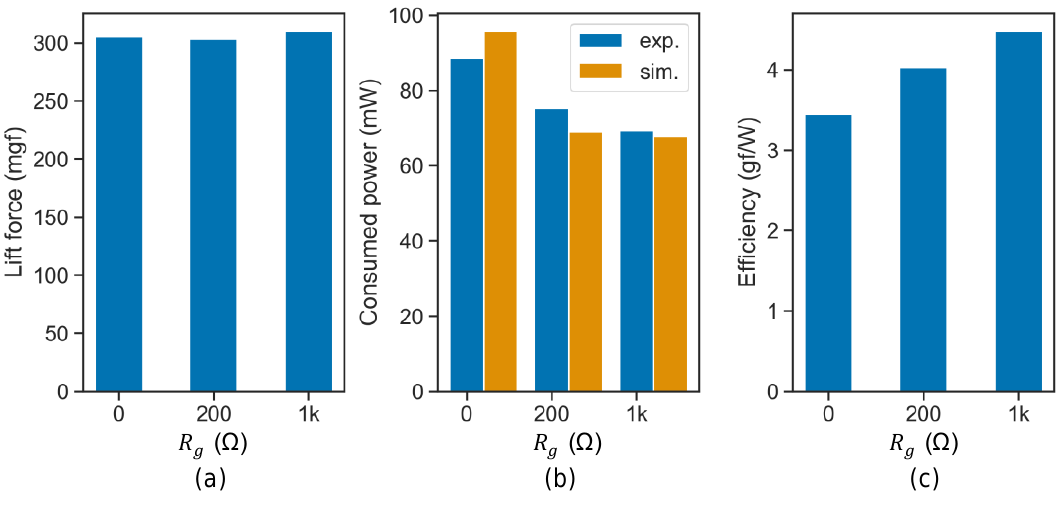
Figure 14. Performance of proposed circuit: ( a ) lift force, ( b ) power consumption, and ( c ) lift-to-power efficiency.